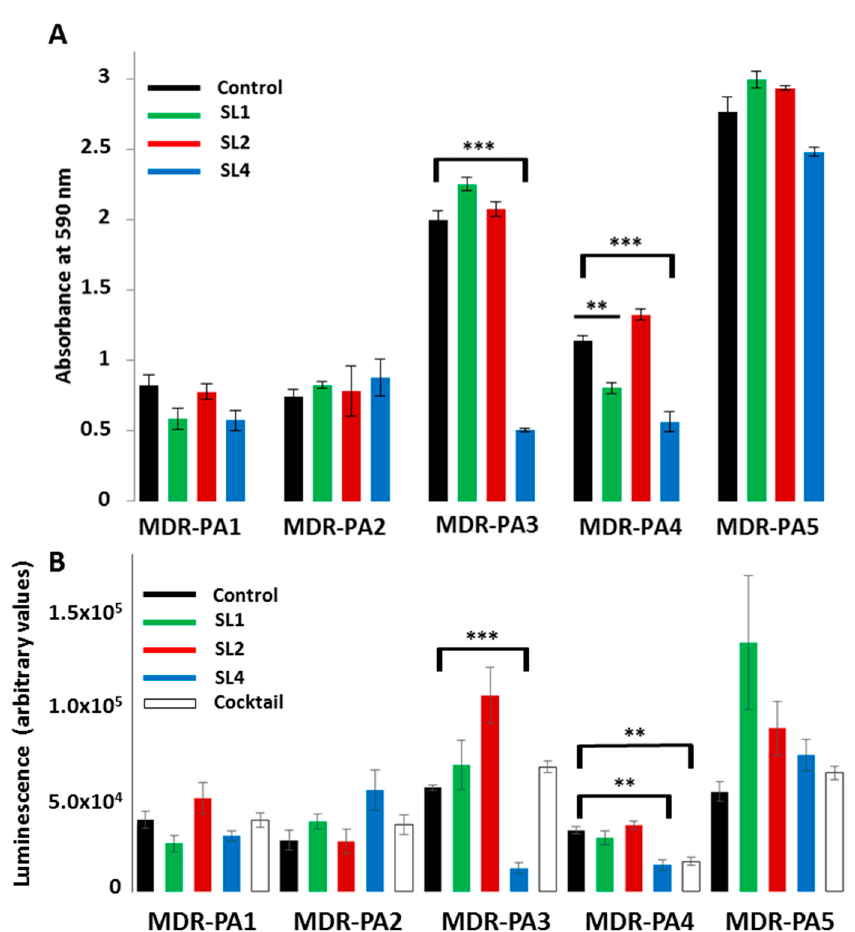
Figure 9. Reduction of 24 h-old biofilms of multi-drug resistant P. aeruginosa strains (MDR-PA1-5) by phages SL1, SL2, and SL4 and a cocktail with all three phages (phage incubation for 3 h, MOI 100): ( A ) Crystal violet assay; and ( B ) ATP-dependent luminescence assay. Each experiment was performed in triplicate and the means ± standard errors are indicated. Statistical significance of biofilm reduction was assessed by performing Student’s t -test. Note that the effect of the cocktail was only evaluated with the method in ( B ). p -Values: *** p < 0.001, ** p < 0.01, * p < 0.05.